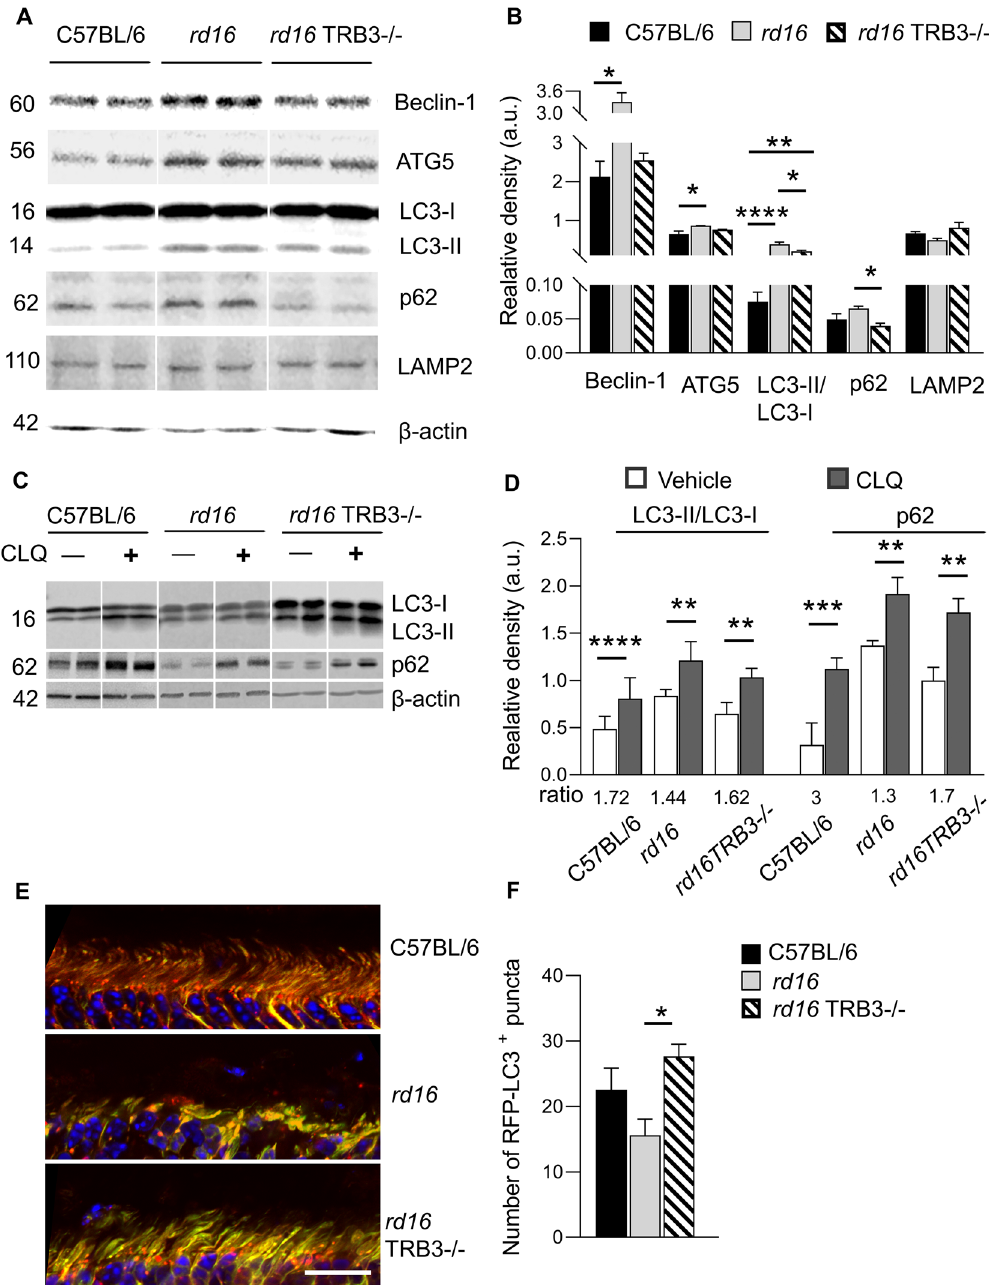
Fig. 4 TRB3 ablation in P15 rd16 retinas resulted in restoration of autophagy-associated protein levels and fl ux. A Images of western blot membranes probed with anti-Beclin-1, ATG5, LC3, p62, and LAMP2 antibodies. B Quantitation of Beclin-1, ATG5, LC3 II/I, p62, and LAMP2 in protein retinal extracts from three groups of mice ( n = 4 – 5). C , D Treatment of retinal explants with chloroquine (CLQ), a classic inhibitor of autophagy, was used to determine the capacity of degenerating retinas to promote autophagosome fusion with lysosomes. C Images of western blot analysis demonstrated LC3 conversion and p62 accumulation. D Quantitation of LC3 conversion in CLQ-treated retinas ( n = 6). The LC3 II/I ratios of the treated retinas were normalized to those of untreated retinas. An increase in induced LC3 conversion was detected in the treated C57BL/6 and rd16 TRB3 − / − retinas. We also observed an increase in p62 level in treated and normalized rd16 retinas as compared to C57BL/6 and rd16 TRB3 − / − ( n = 4 – 5). E , F The RFP-GFP-LC3 transgene expression in mouse retinas demonstrated the generation of red puncta in the inner segments of photoreceptors. E Images of the retinal sections of C56BL/6, rd16 , and rd16 TRB3 − / − mice taken with a confocal microscope. F Quantitation of the red puncta cells in the retinal sections of the three groups of mice ( n = 5 – 7). Data are shown as mean ± SEM; * p < 0.05, ** p < 0.01, *** p < 0.001, and **** p < inhibitor of autophagy, to determine the capacity of autophago- C57BL/6 mice detected by western blot analysis, but this reduction somes in degenerating retinas to bind and deliver LC3 II to was not statistically different. lysosomes (Fig. 4C, D). We observed that the LC3 conversion from I Given that LC3-II/I conversion is increased in rd16 retinas, we to II was limited in the CLQ-treated rd16 mice, while the treated next treated degenerating retinas with chloroquine (CLQ), a classic